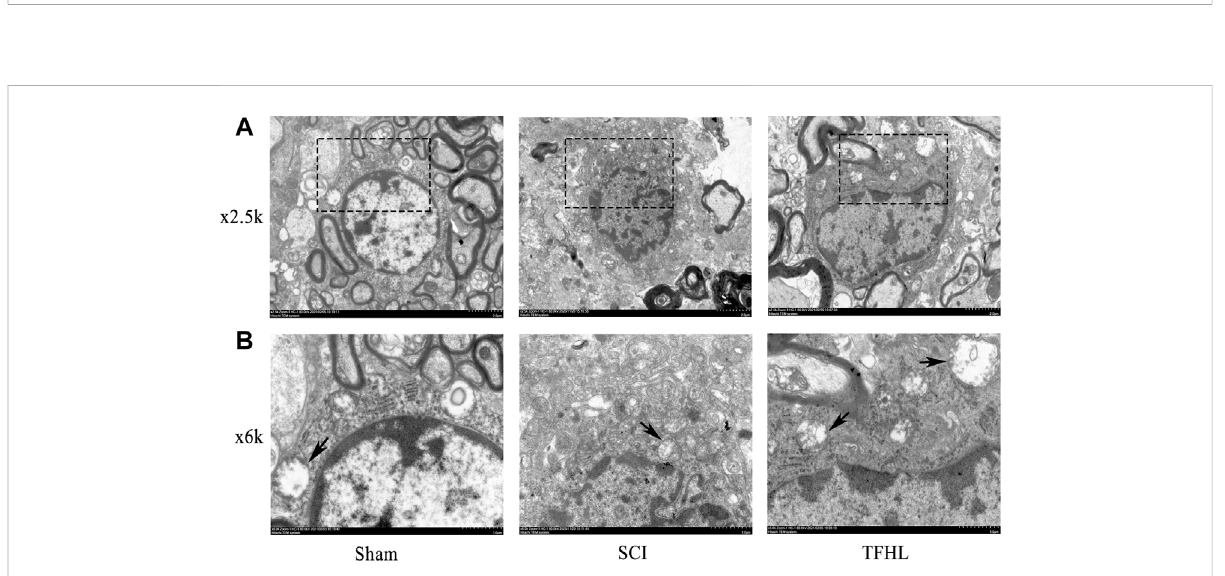
FIGURE 3 TFHL facilitates microstructure and autophagosome change of injured spinal cord tissues. Observation of microstructure and autophagosome change in spinal cord sections of each group by transmission electron microscopy ( n = 3, cross-section of the T10 segment of spinal cord). (A) Under ×2.5 k electron microscope, the changes of neuronal nuclei and surrounding myelin sheaths in spinal cord tissue of each group were observed,withscalebars=2 μ M. (B) Underthe×6 kelectronmicroscope,theautophagosomesincellswerefound,withscalebars=1 μ M.The black dashed box is the observation site under ×6 k magni fi cation, and the arrow points to the